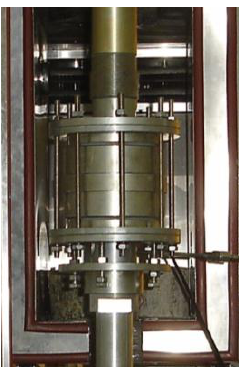
Figure 2. Diagram of triaxial test.